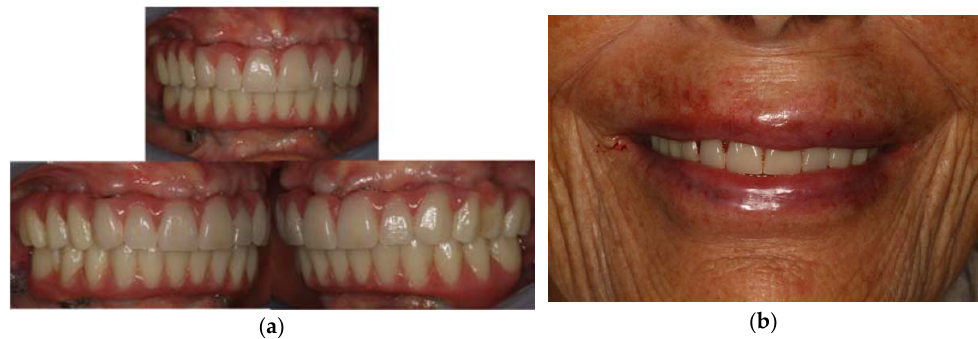
Figure 9. Final result of the prosthesis: ( a ) intra-oral view; ( b ) extra-oral